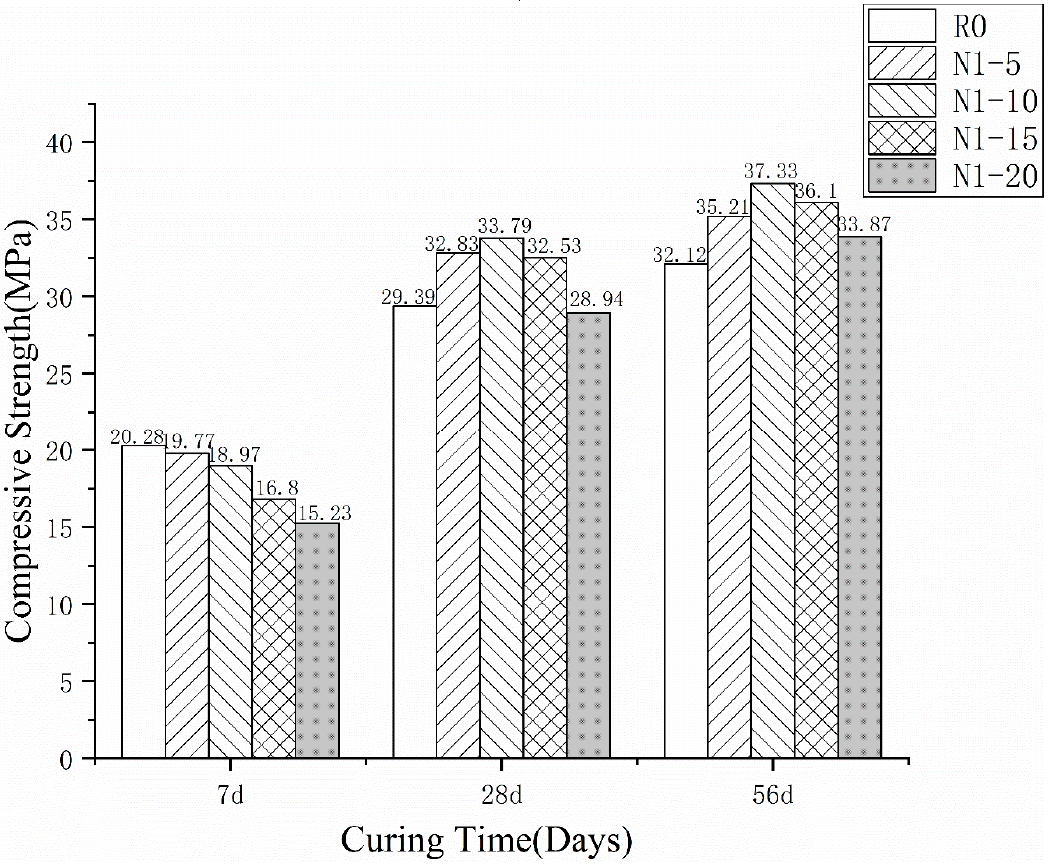
Figure 3. Compressive strength of different RHA rate cement at 7, 28, and 56 d.